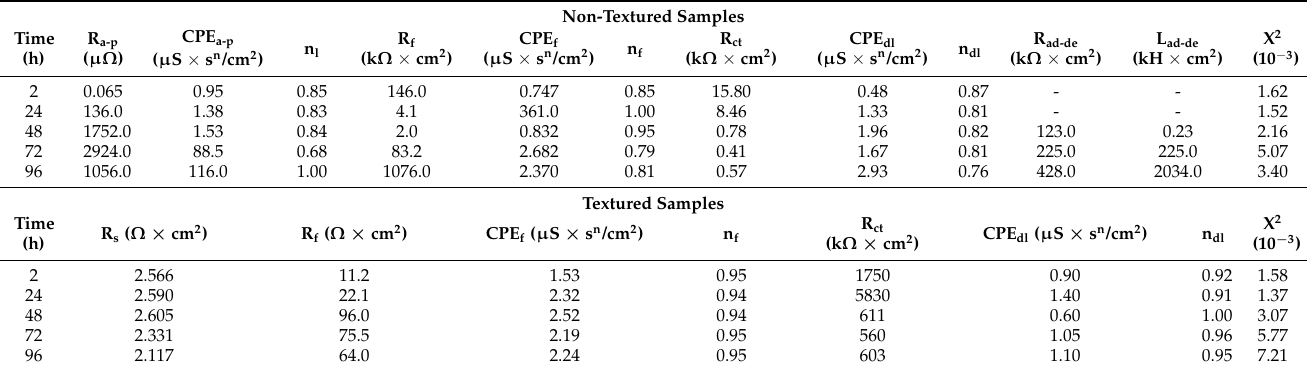
Table 5. Summary of the equivalent circuit element values according to the samples and immer- sion